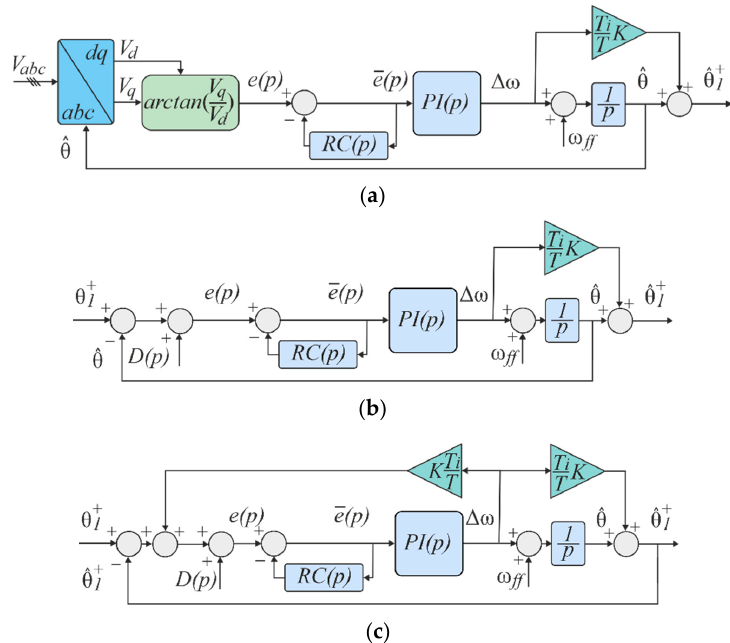
Figure 5. RCE-PLL. ( a ) Block diagram; ( b ) small-signal model; ( c ) different form of the small-signal model.